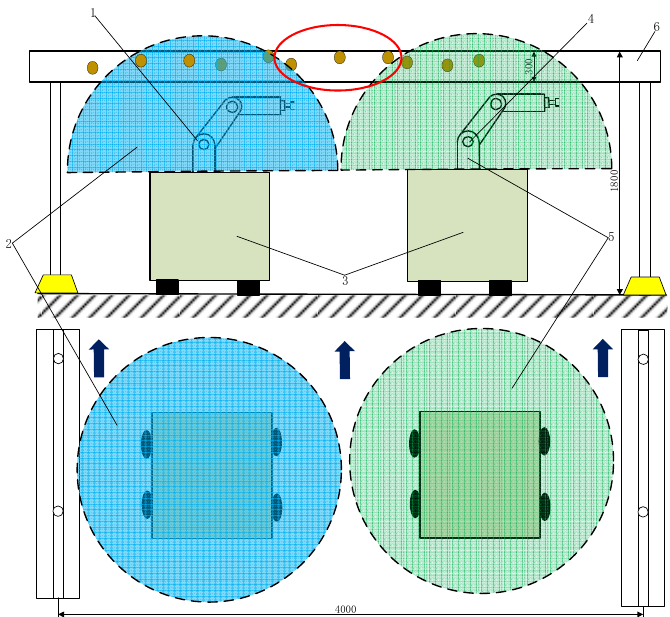
Figure 4. Schematic diagram of multi-robots working: 1—left robotic arm; 2—left robotic arm workspace; 3—mobile platform; 4—right robotic arm; 5—right robotic arm workspace; 6—shelf.